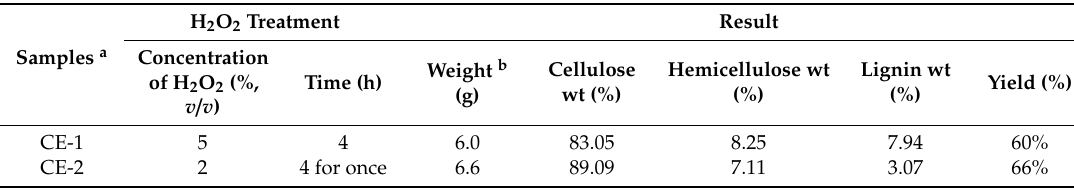
Table 1. Chemical composition of extracted